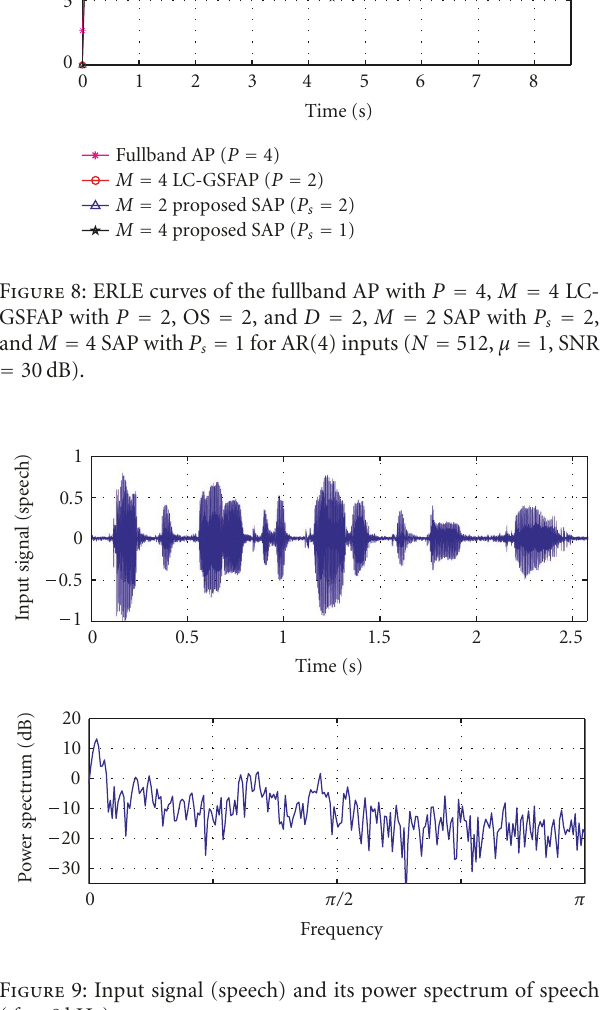
Figure 9: Input signal (speech) and its power spectrum of speech ( f s = 8kHz).